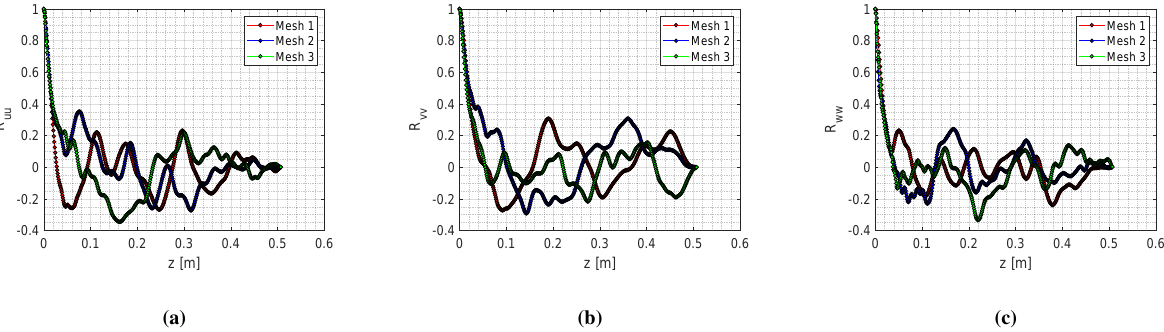
Figure 17: Two-point auto-correlation of the components of the velocity fluctuations along the centerline Figure 17. Two-point auto-correlation of the ( a ) stream-wise, ( b ) wall-normal, ( c ) span-wise components of the velocity fluctuations along the centerline.